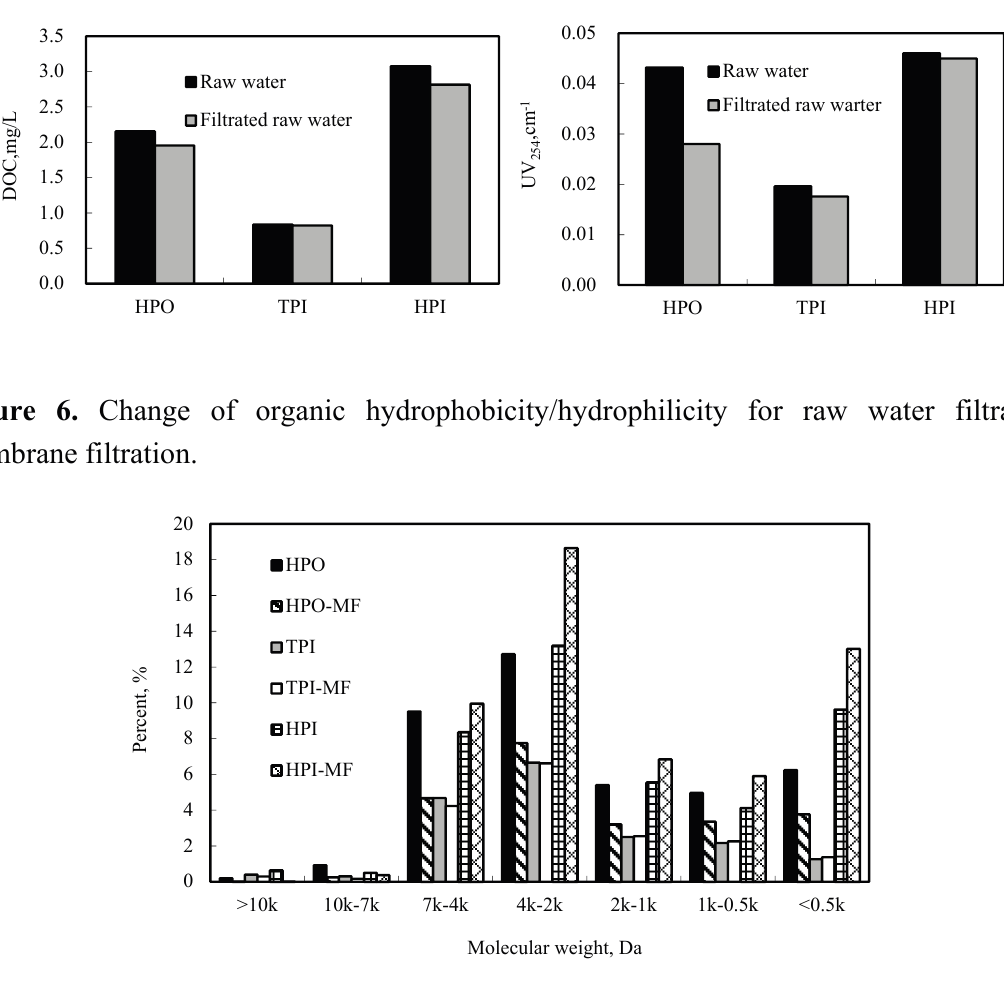
Figure 7. Change of organic matter molecular weight (MW) in raw water before and after membrane